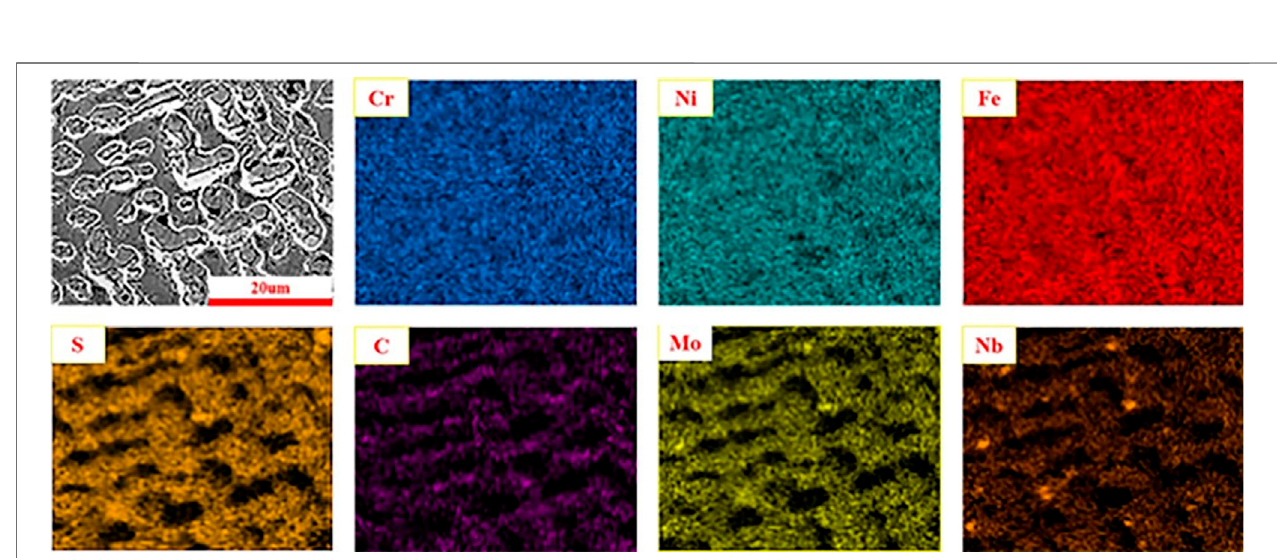
FIGURE 5 | Metallographic microstructure of the weld. (A) Backing bead. (B) Interface area of the bead. (C) Filler bead. (D) Cover bead.